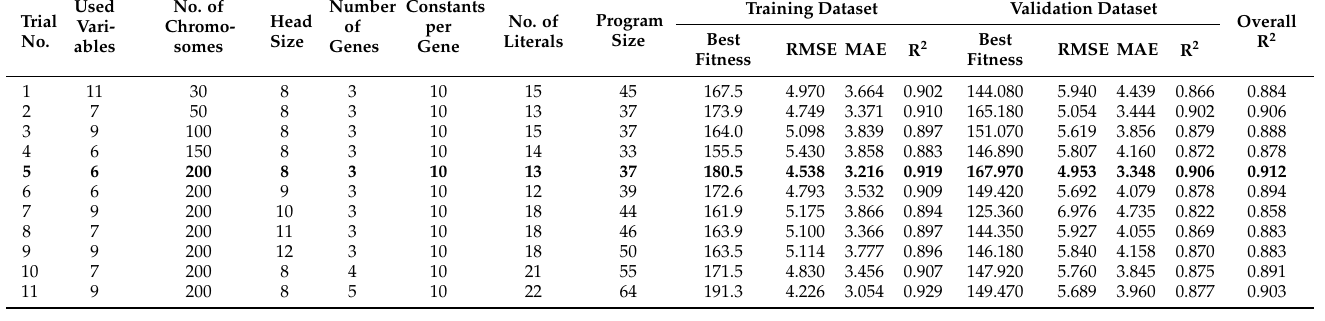
Table 3. Details of trials and their statistical evaluation using correlation and error indices.